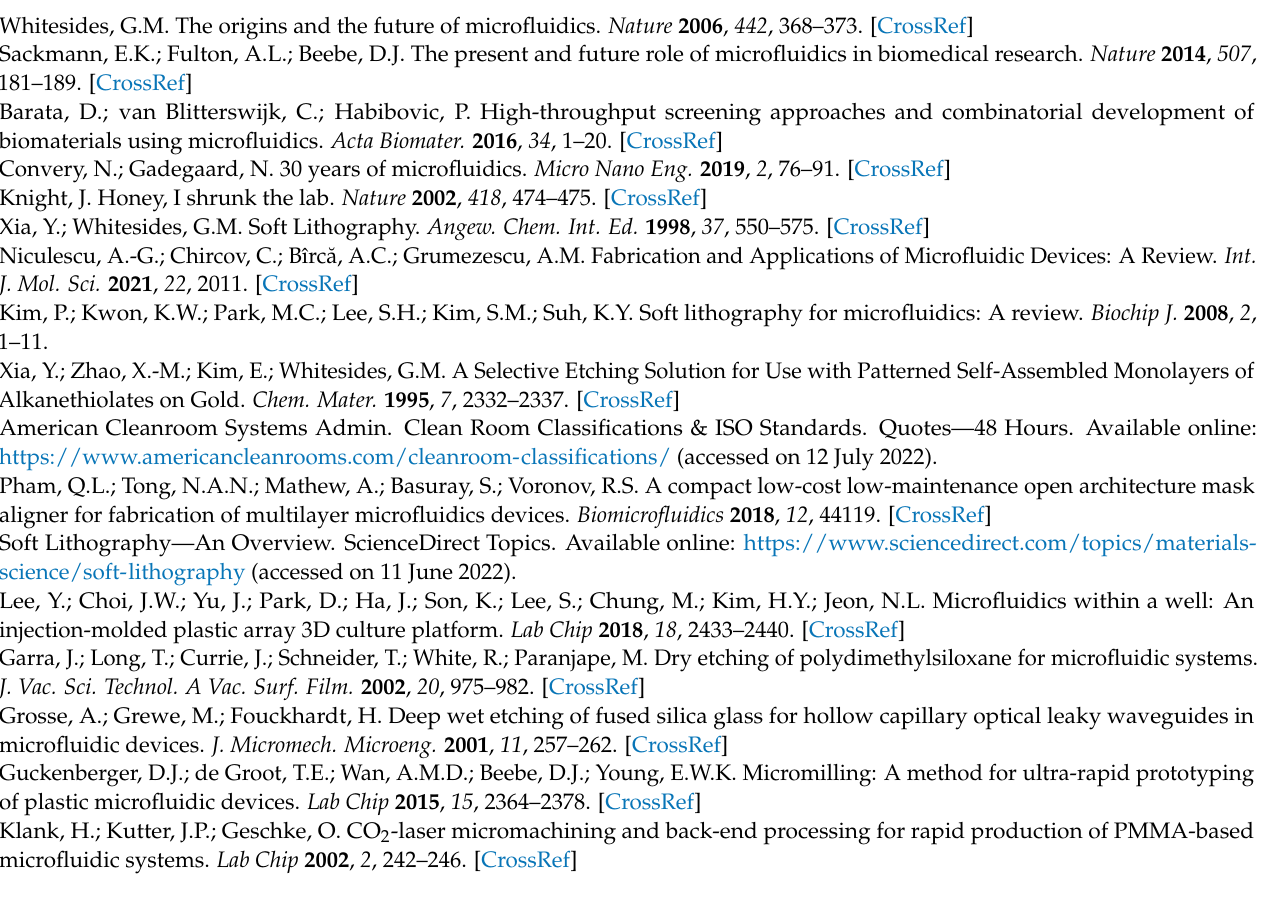
to the x-y plane; Figure S5: Flow diagram of the primary steps for setting up the load cell and collecting the data; Figure S6: Side view and top view of the apparatus; Figure S7: (a) apparatus for mechanical stress test of the printed models. (b) 3d printed “dog-bone” shaped models using custom resin. (c) snapping point; Figure S8: Colorimetric LAMP validation of Lamda DNA. A. Photograph of the amplified DNA sample using 3D printed reaction chamber. B. Traditional tube based colorimetric LAMP validation for Lamda DNA; Table S1: Specifications of masked-stereolithography printers used in this study; Table S2: Resin optimum exposure times for commercial and custom resins used in this study; Table S3: Specifications of masked-stereolithography printers used in this